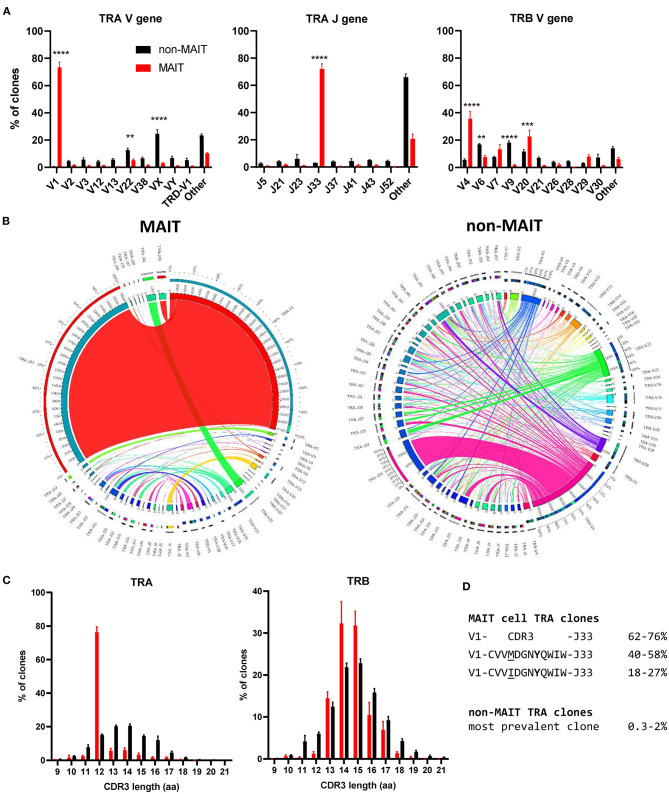
Conserved TCR alpha chain and limited beta chain diversity in bovine MAIT cells. (A) Bar graphs showing TCR alpha (TRA) V and J and TCR beta (TRB) V gene usage in MAIT (CD8+ MR1-5-OP-RU tetramer+) and non-MAIT (CD8+ MR1-5-OP-RU tetramer−) T cells. Bars represent the percentage of total TRA or TRB sequences obtained from high throughput TCR sequencing of populations sorted from PBMC (mean ± SEM, n = 4, number of sequences in Supplementary Table 1). Data were analyzed using two-way ANOVA with repeated measures within animal, followed by Sidak's multiple comparisons post-hoc test comparing gene usage between MAIT and non-MAIT T cells. (B) Circos plots showing TRAV-J combinatorial diversity within MAIT and non-MAIT T cells. The inner circle shows the number of sequence reads per V and J gene and TRAV/J combinations are indicated by proportional bands linking the genes using the color of the V gene. The outer ring shows the frequency of pairing for each TCR gene segment to the reciprocal gene segment colored according to the paired gene. Representative plots from a single individual. (C) Distribution of TRA and TRB CDR3 amino acid (aa) length. (D) Alignment of the TCR alpha CDR3 region of the dominant MAIT cell clones.